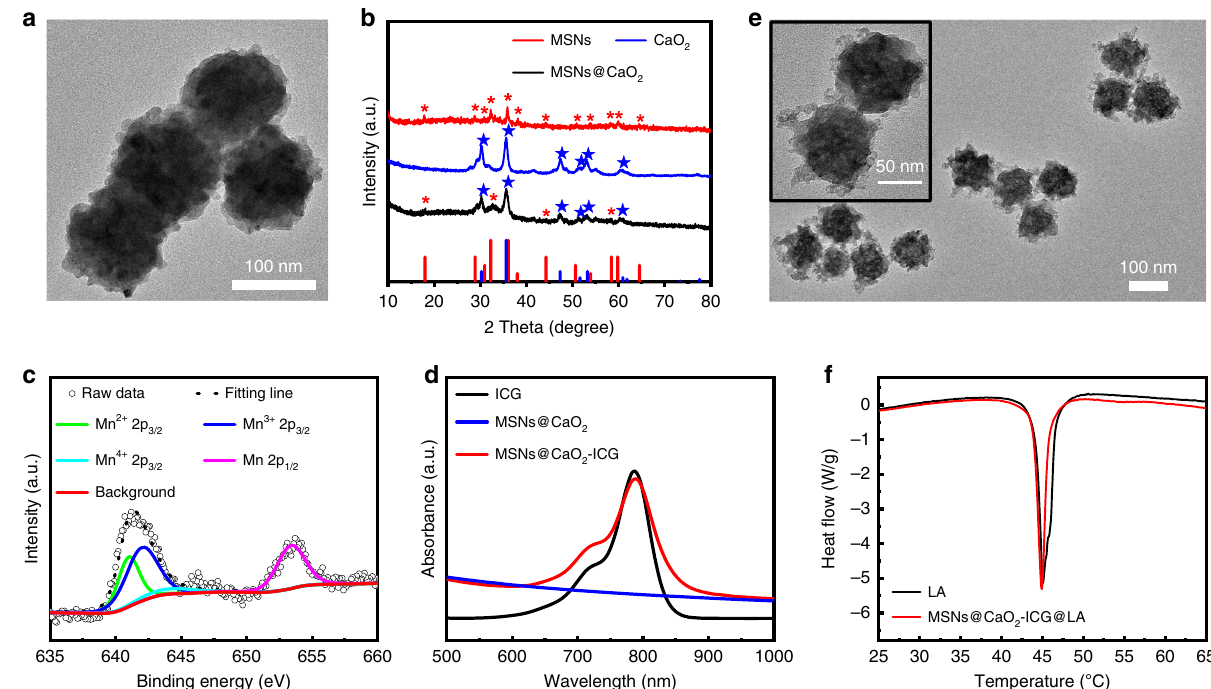
Fig. 2 Physiochemical characterizations. a TEM images of MSNs@CaO 2 NPs. b XRD spectra of MSNs, CaO 2 NPs, and MSNs@CaO 2 . c High-resolution Mn 2p XPS spectra of MSNs@CaO 2 . d UV-vis spectra of ICG, MSNs@CaO 2 , and MSNs@CaO 2 -ICG. e TEM images of (MSNs@CaO 2 -ICG)@LA. f DSC curves of LA and (MSNs@CaO 2